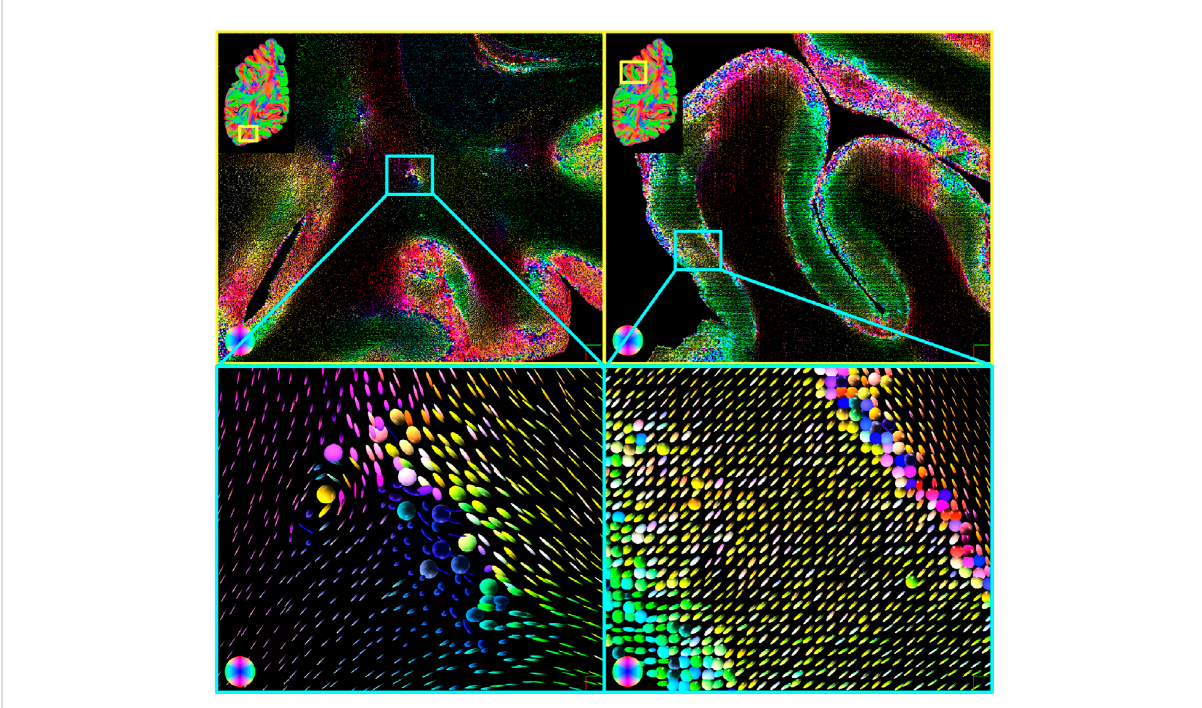
FIGURE 9 Fiber orientation uncertainty ellipsoids for human brain data. The color of the ellipsoids corresponds to an RGB color coding of their principal fi ber orientation. Using the ellipsoids, regions with greater uncertainty in the signal can be intuitively identi fi ed (top). These regions are located, for example, in regions of fi ber crossings (bottom left) or at the border from white to gray matter and in the cortex (bottom right). Very slim ellipsoids characterize white